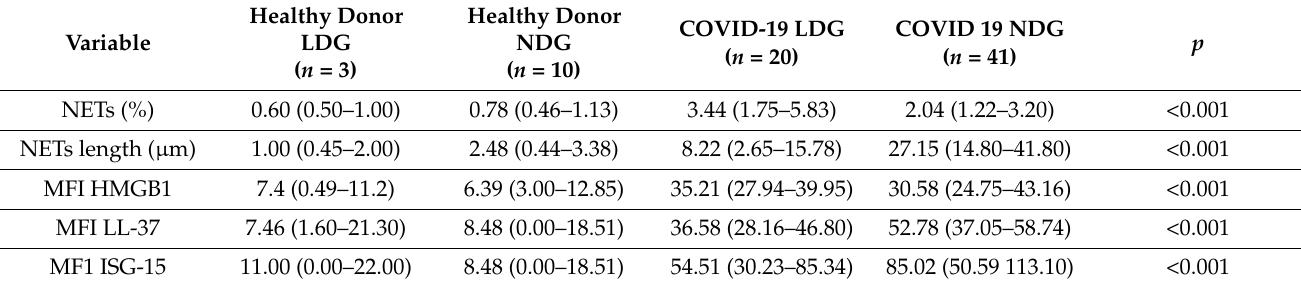
plexes were lower in patients with severe COVID-19.